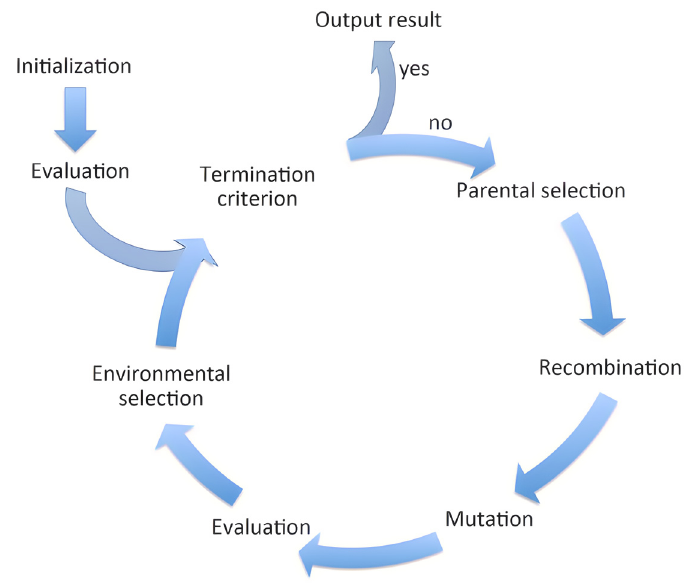
Figure 16. Flowchart of a basic genetic algorithm.